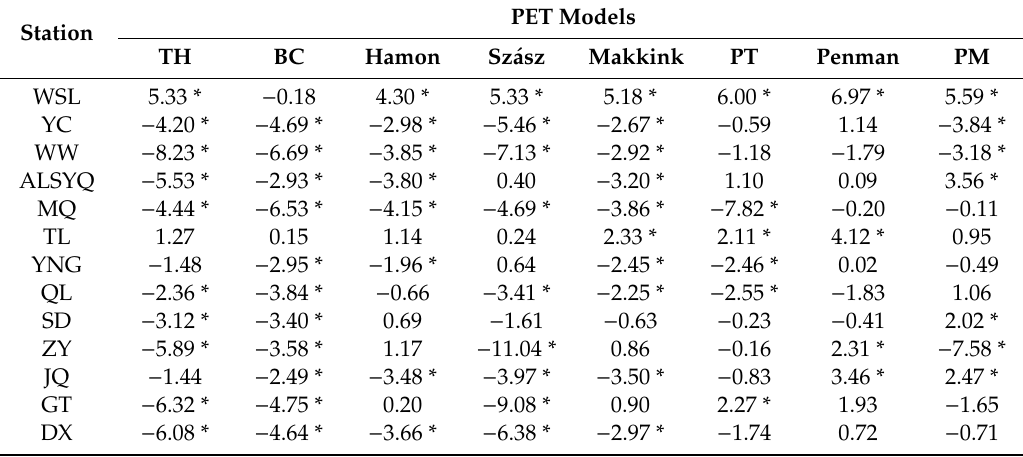
Table 5. Z-statistic values of trend analysis by using the MK test (1960–2015).